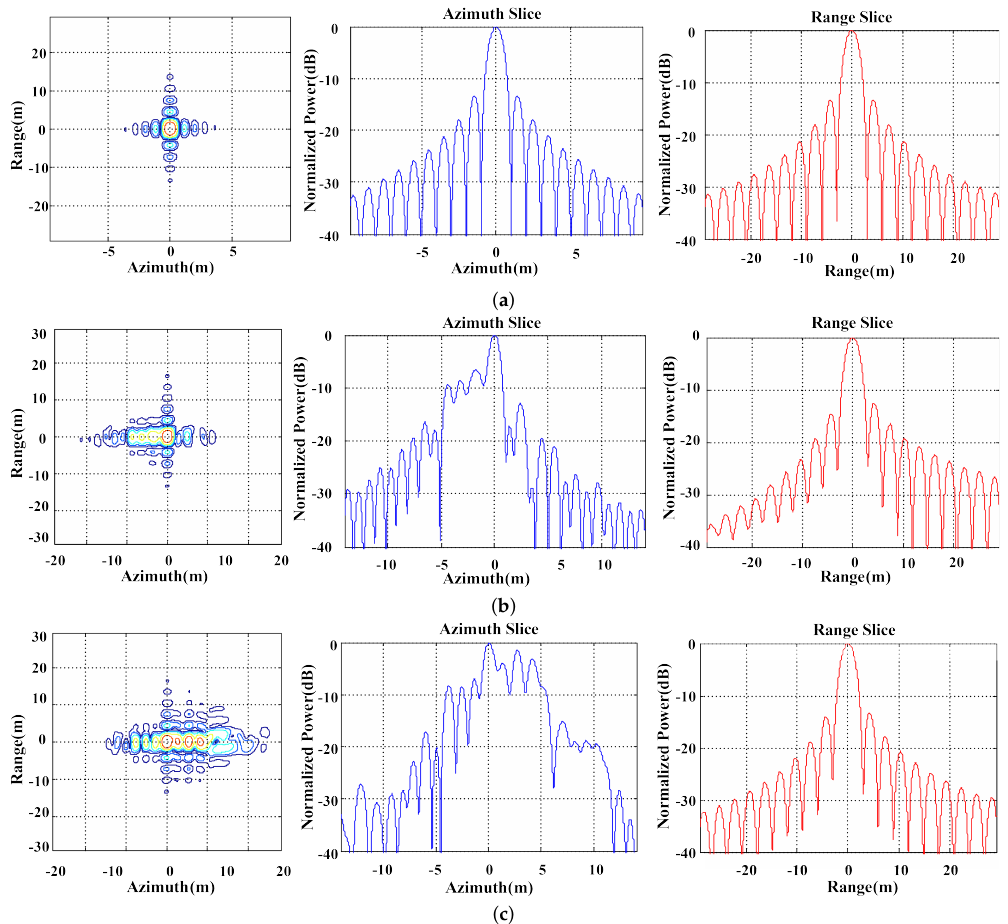
Figure 11. The simulation results of point targets. ( a ) Ideal imaging results. ( b ) Scintillation imaging result for C k L = 10 33 . ( c ) Scintillation imaging result for C k L = 10 34